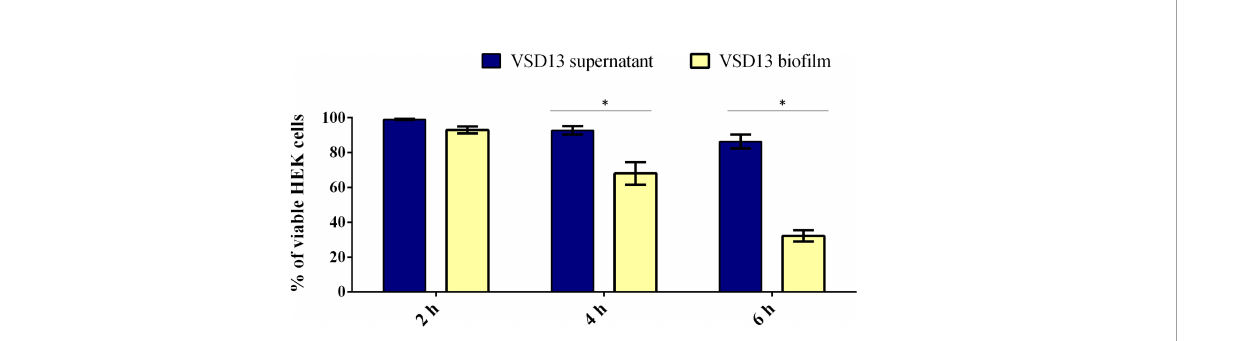
FIGURE 3 Viability of HEK cells exposure to SDSD VSD13 sessile cells or bacterial supernatants for 2 h, 4 h and 6 h. The following equation was applied: cell viability (%) = 100 x [mean Abs SDSD cells (or mean Abs bacterial growth supernatant)/mean Abs control group]. Data are the average of at least three independent (biological) assays with three technical replicates each. Error bars correspondent to standard deviation. Statistically signi fi cant differences were observed in the viability of HEK cells exposure to SDSD VSD13 sessile cells and bacterial supernatants at 4 h and 6 h, * p <